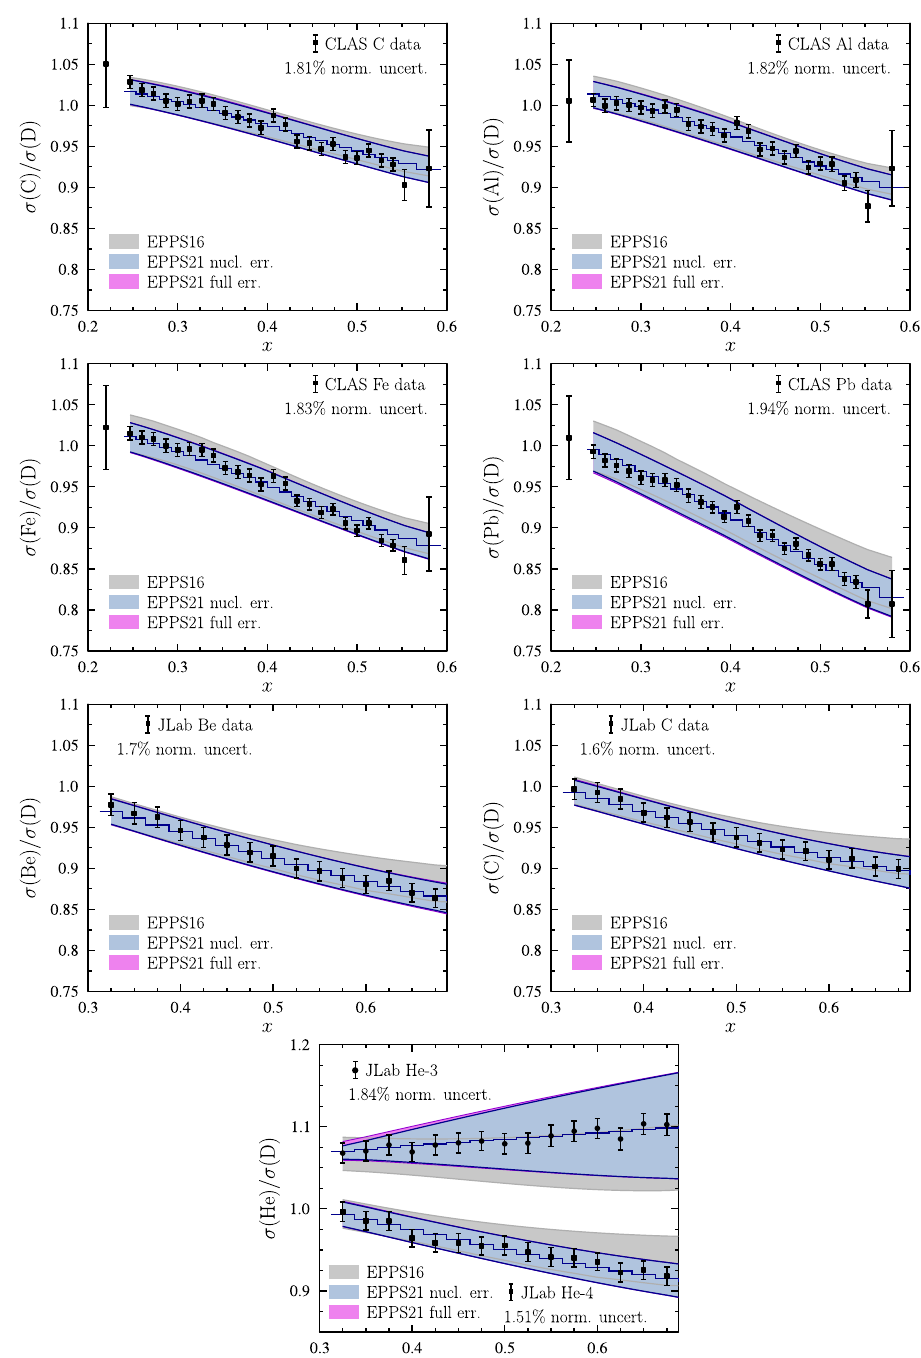
Fig. 13 The JLab CLAS [14] and Hall-C data [13] compared with the EPPS21 and EPPS16 analyses. The solid blue lines show our central results, inner blue bands the nuclear uncertainties, and the purple bands the total uncertainty. The grey bands correspond to the EPPS16 results. The experimental data have been scaled with the normalization factors indicated in Table